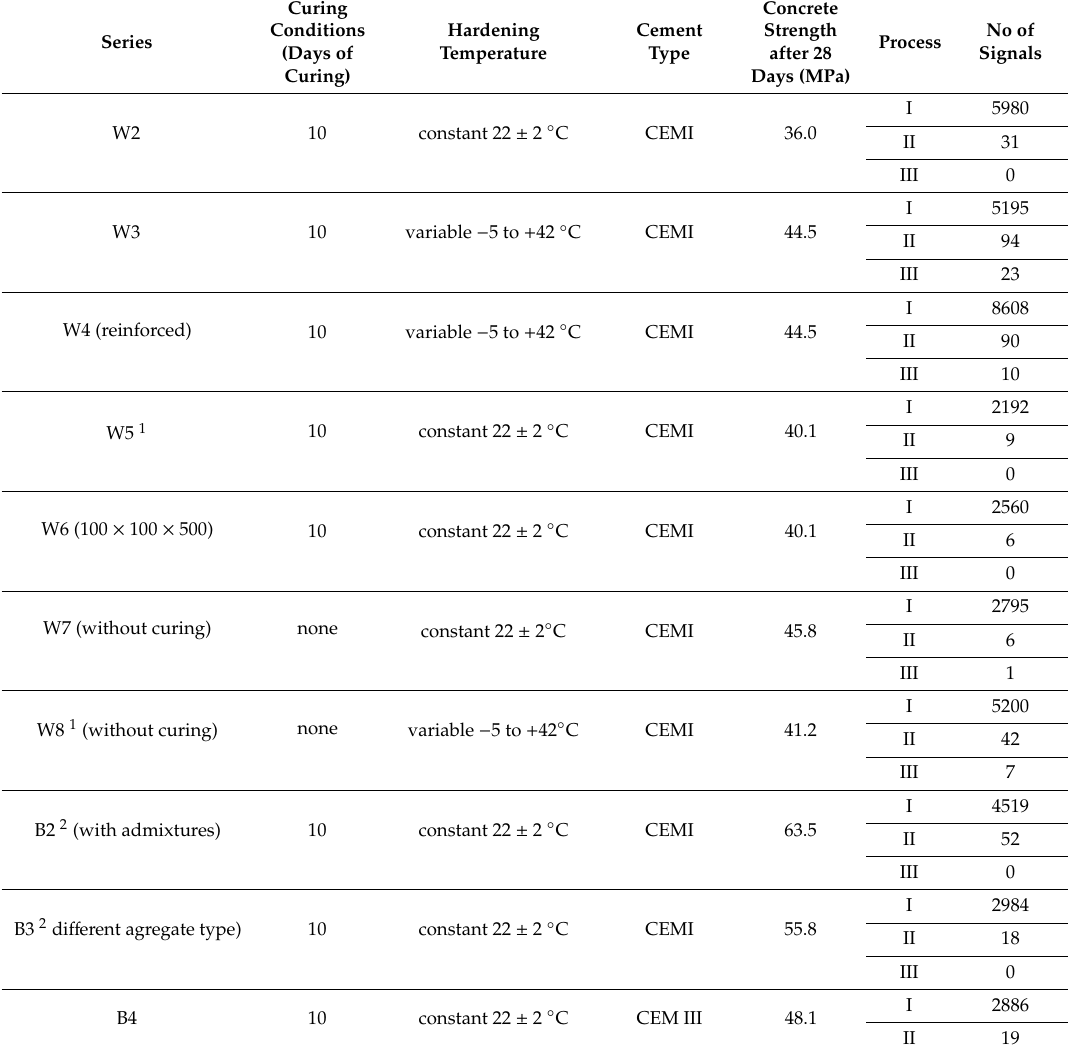
Figure 14. Number of hits accompanying processes I–III recorded in W3 and W4 samples (10 days curing, varied temperature, and with and without reinforcement).